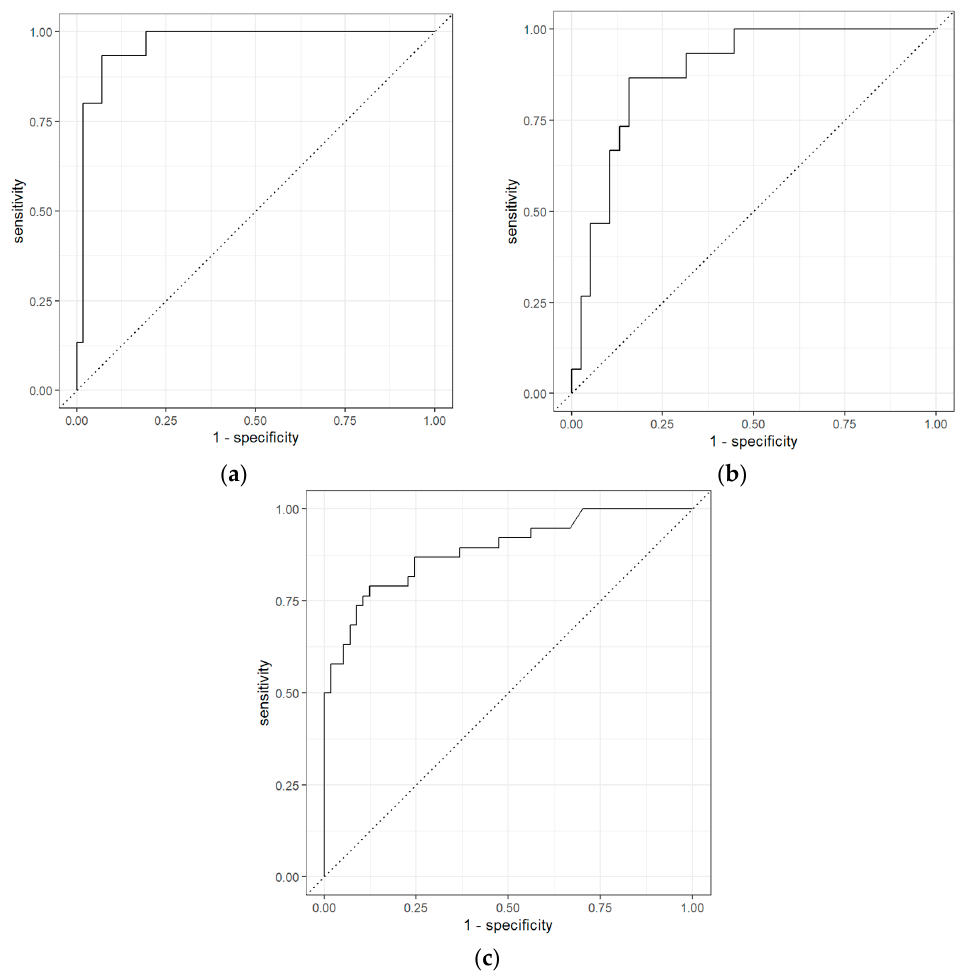
Figure 4. Receiver operator characteristic for ( a ) bladder cancer vs. PCa; ( b ) bladder cancer vs. non-cancerous group; and ( c ) prostate cancer vs. non-cancerous group using GC-IMS.